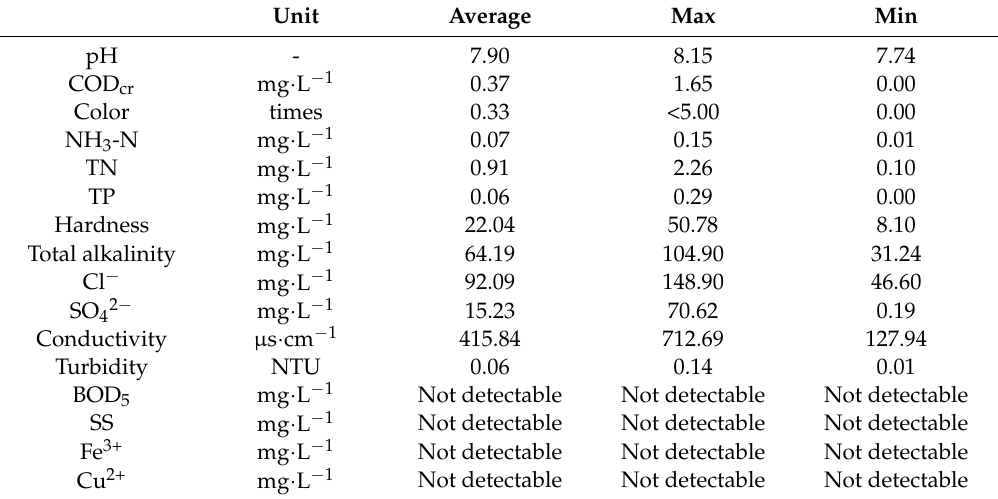
Table 3. Pollutants of the effluent after the primary RO treatment.